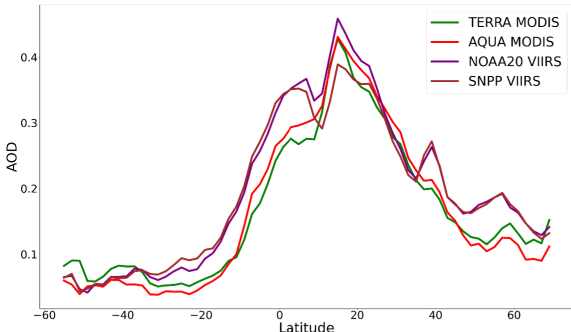
Figure D2. Latitude cross-section of temporal mean satellite AOD for the MAM period over land.